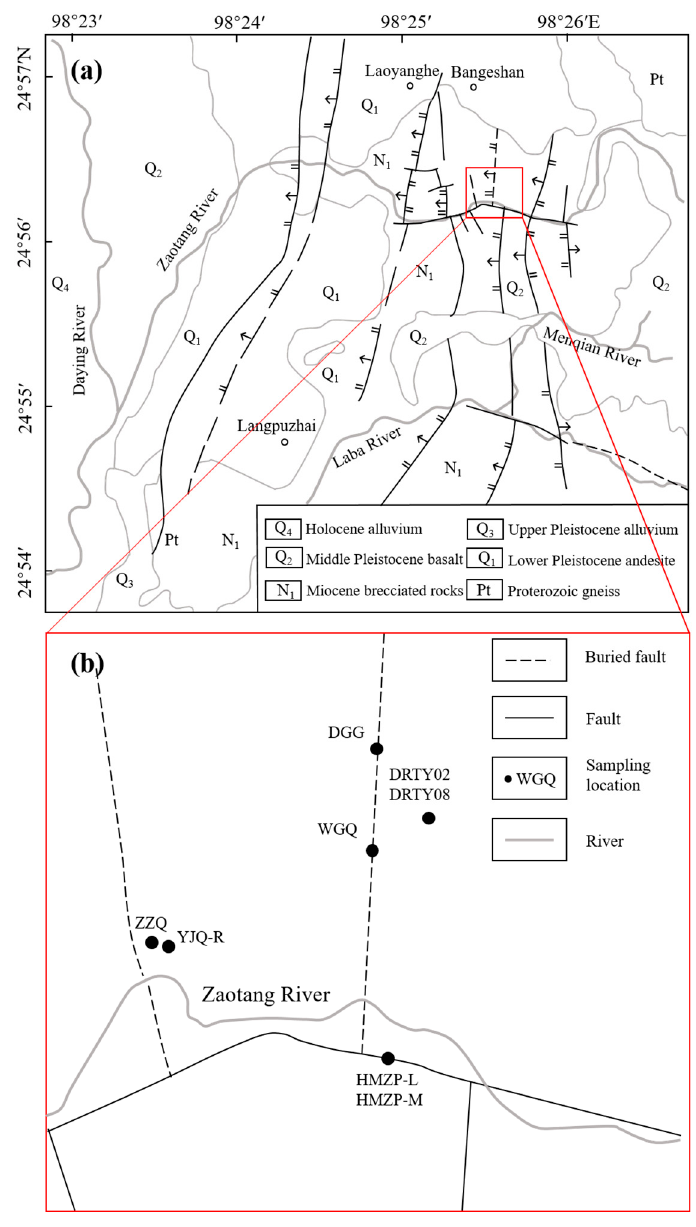
Figure 1. Simplified geological map of the Rehai geothermal field based on [40] ( a ) and sampling locations ( b ).